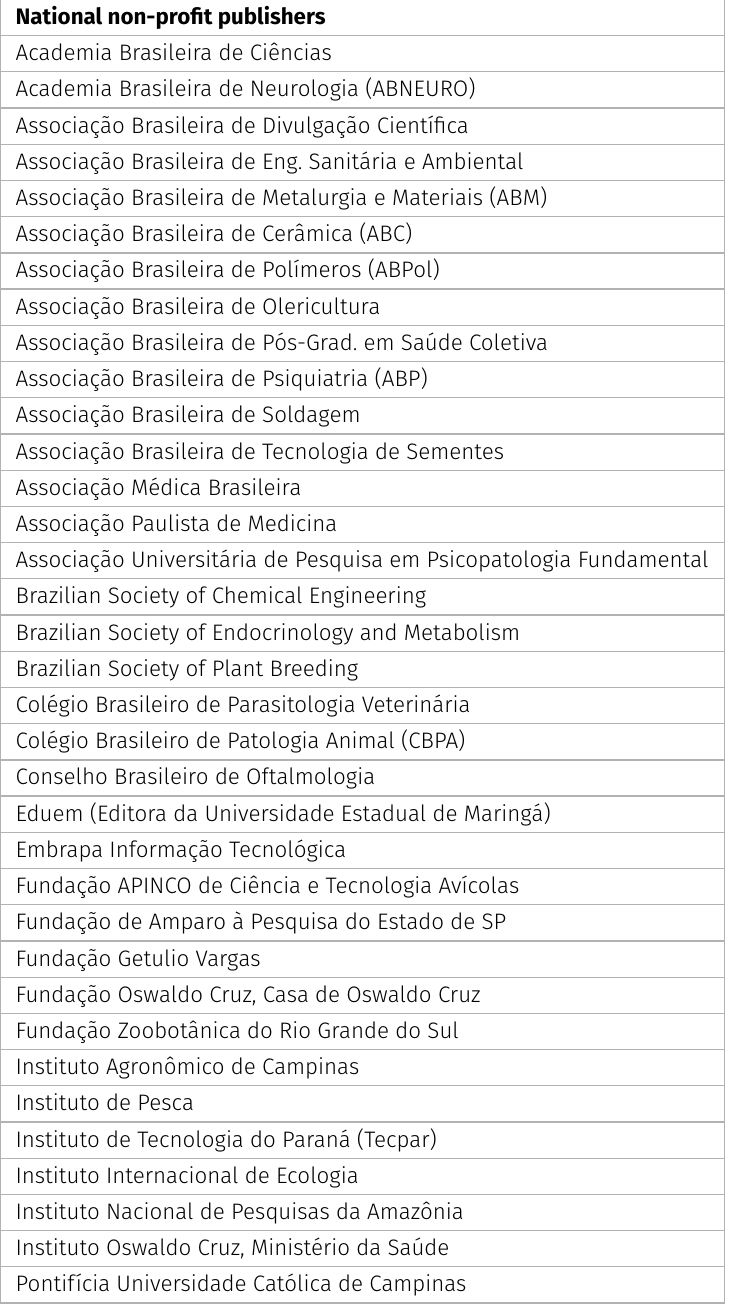
Table III. National non-profit publishers considered in the survey. (Web of Science